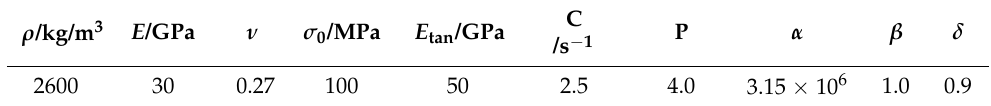
Table 2. Main calculation parameters of rock [7,9].